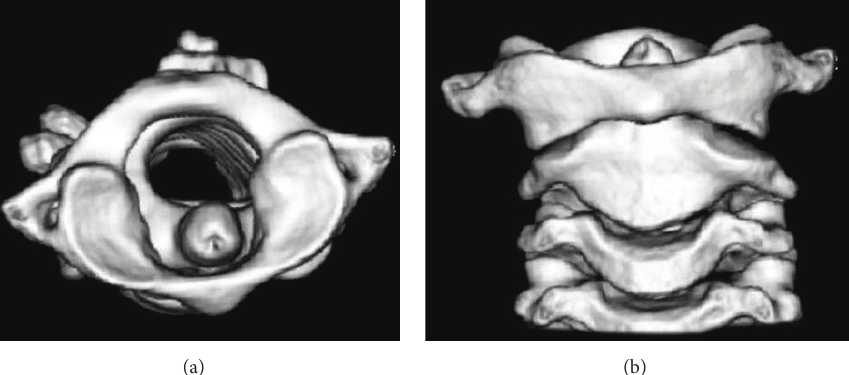
Figure 1: Axial (a) and coronal (b) view of 3DCT before treatment. The atlas was rotated without dislocation of the odontoid process in axial view. The axis showed slight oblique position against atlas in coronal view.